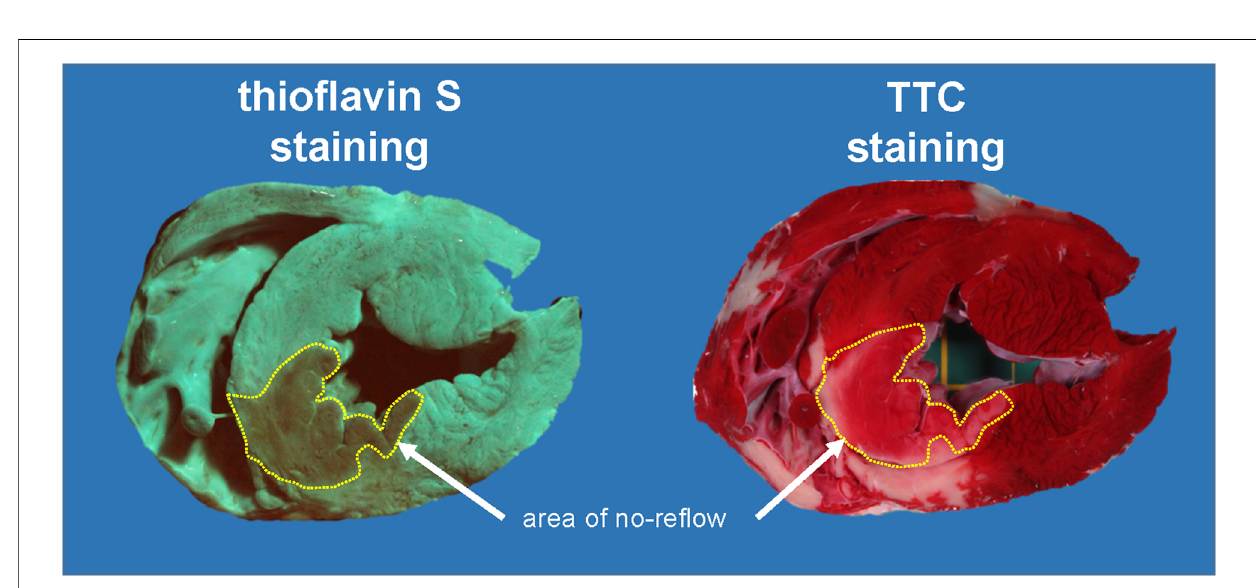
FIGURE 3 Original heart slice after demarcation of areas of no-re fl ow with thio fl avin-S and after demarcation of avital tissue by TTC staining. The thio fl avin-S- negative stained area (no-re fl ow) is indicated in both images. Almost the entire area of no-re fl ow is stained TTC positive. This pig had profound hypotension with intravenous diazoxide given over 10 min just before reperfusion (left ventricular pressure: 42 mmHg at 55 min ischaemia and 53 mmHg at 10 min reperfusion). TTC, triphenyl tetrazolium